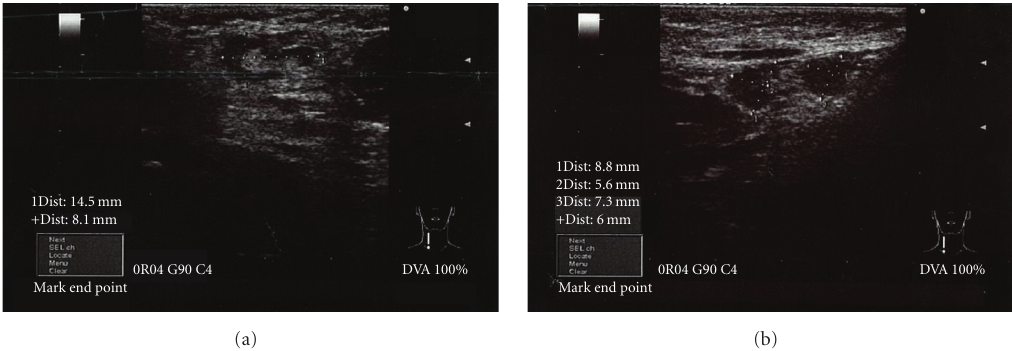
Figure 1: USG scans of the right axillary area taken one day after the vaccination on the 9th of December 2009.